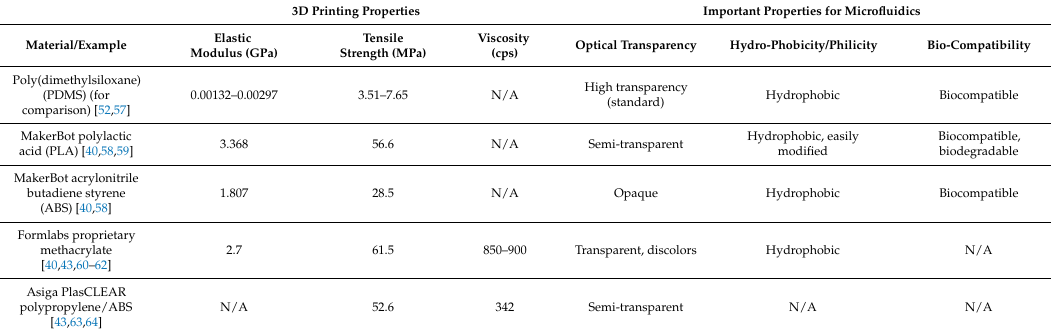
Table 1. Materials for 3D